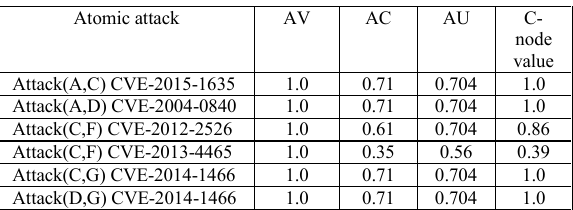
Table 1. C-node values associated with each atomic attack Atomic attack